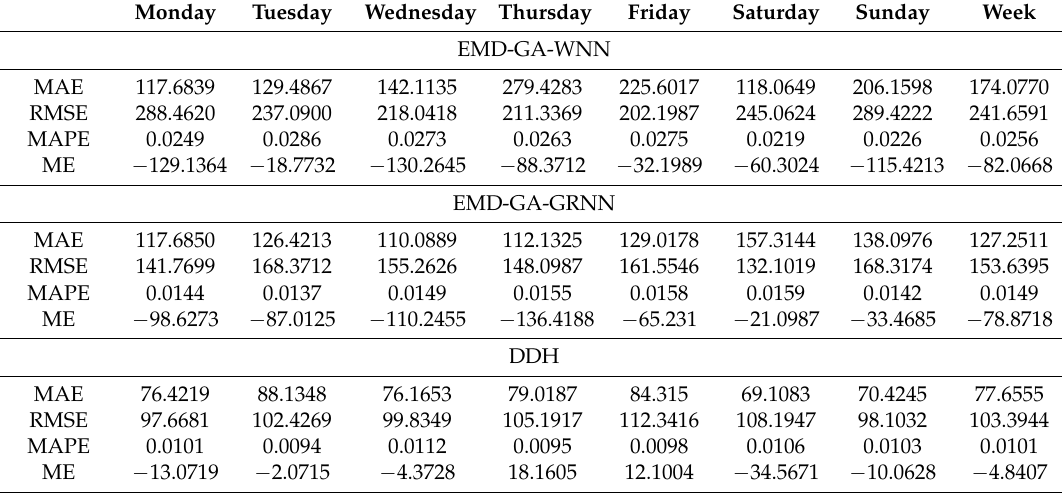
Table 4. Forecasting performance evaluation results of one week with larger training set.